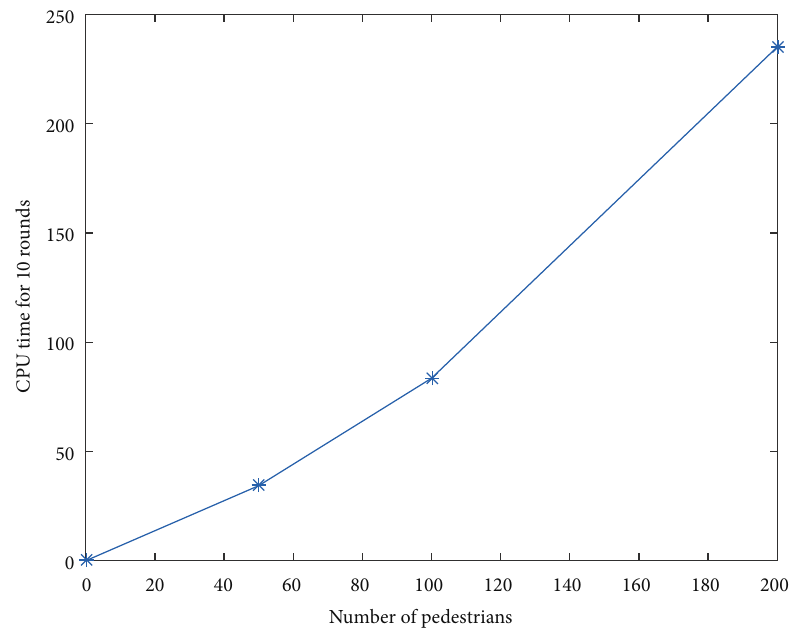
Figure 10: Computation time of 50, 100, and 200 pedestrians in case of 5% guiders in simulations. The entire time period of a simulation is 50s. The simulation room consists of two exits as Figure 3(b).